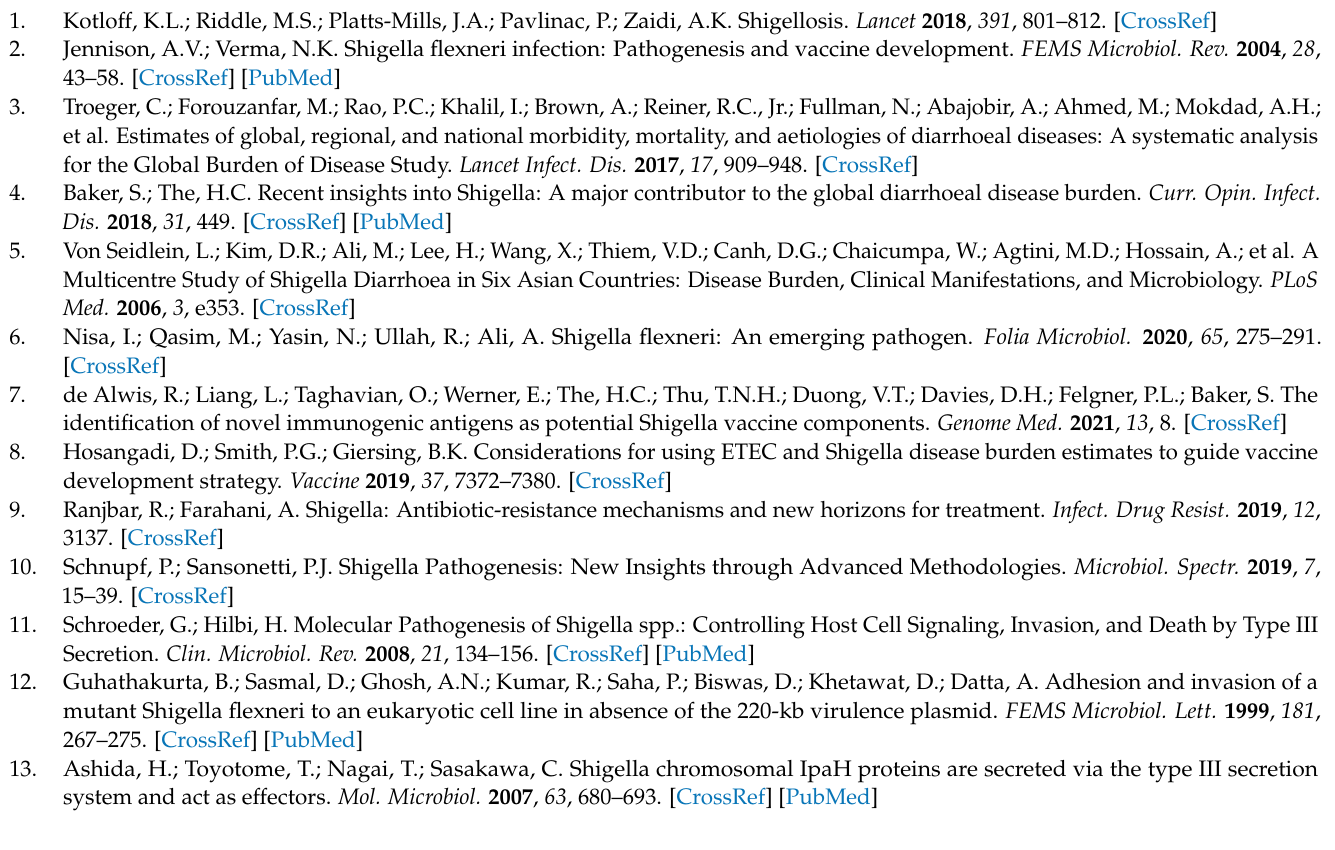
plasmids used in this study. Table S2. Primers used in this study. Table S3. UniProt accession number of the YfiB protein sequences used in this study for in silico